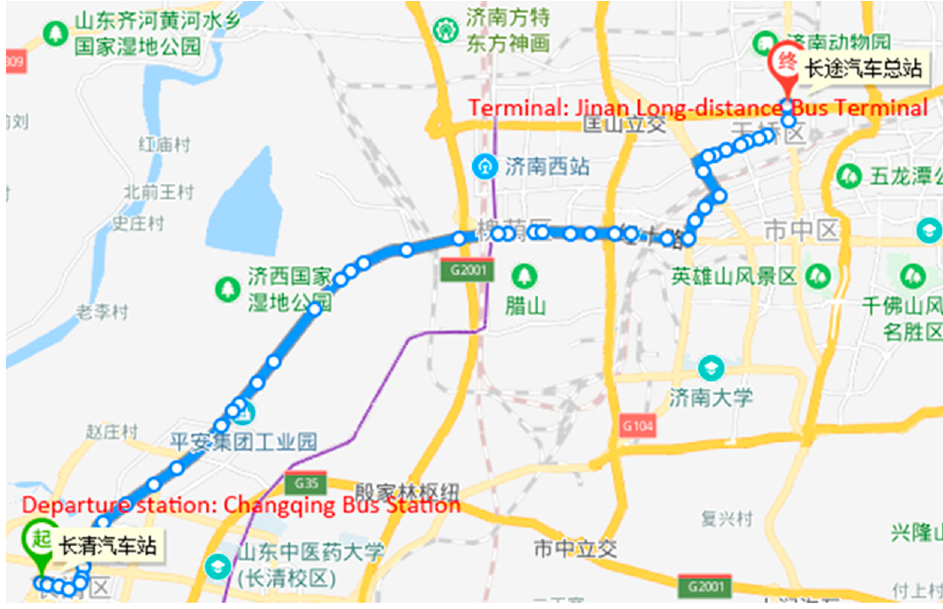
Figure 3. The single route selected. Source: Baidu Maps.